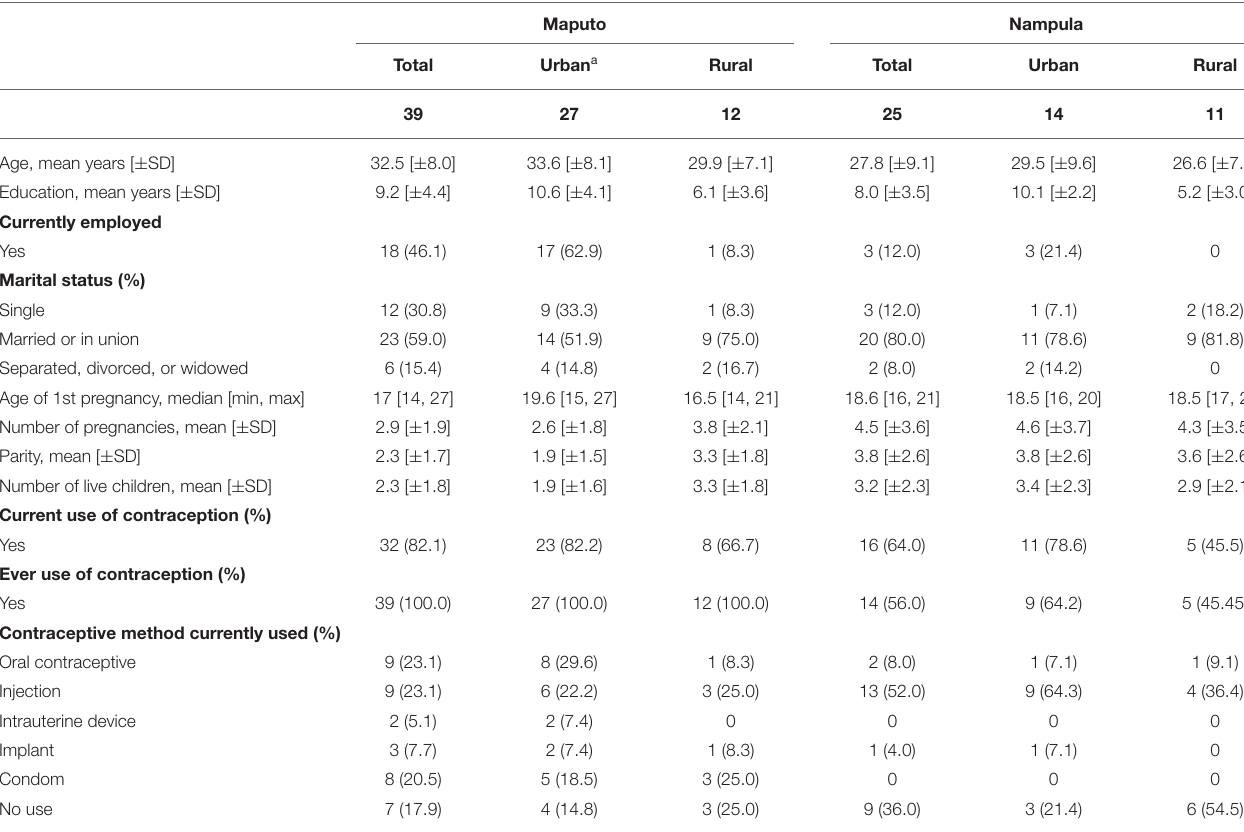
TABLE 1 | Sociodemographic and economic characteristics of participants from urban and rural areas of Maputo city and province and Nampula